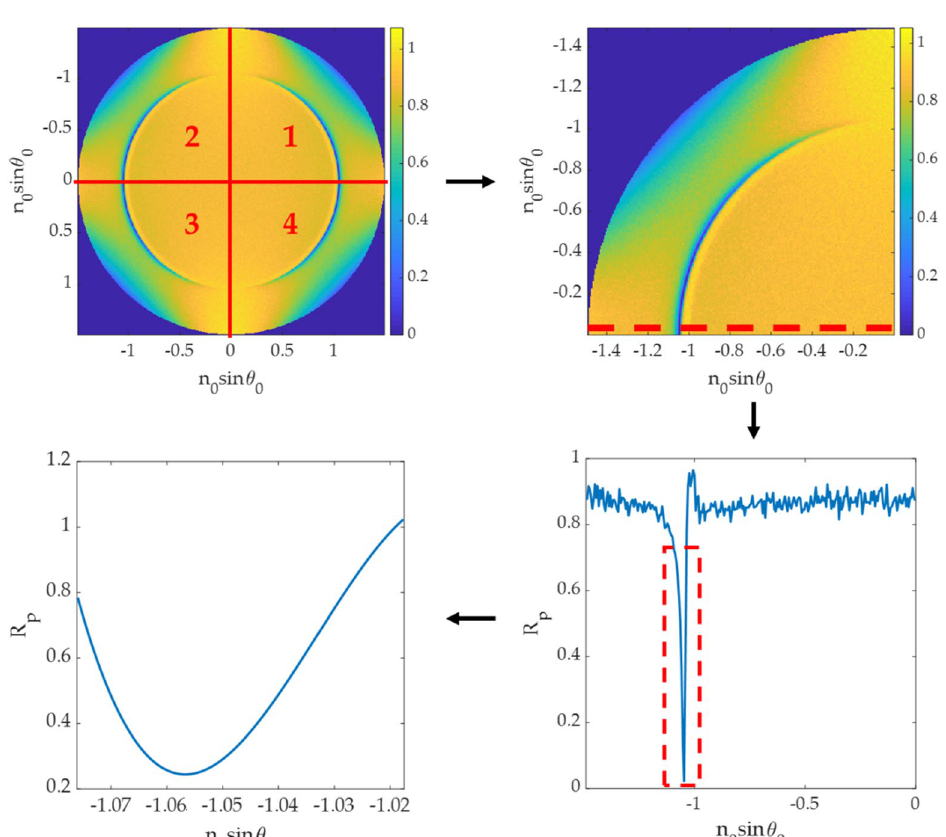
Figure 7. Steps in determining plasmonic angle from a BFP